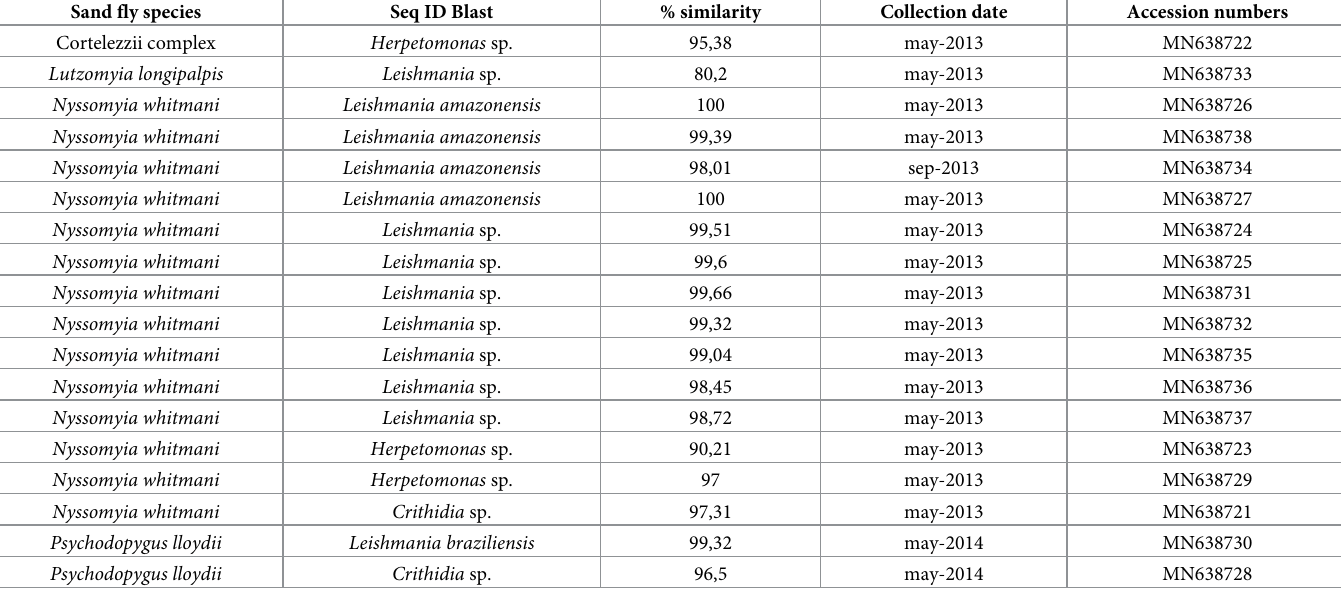
Table 3. Results of DNA detection and identification of species of Trypanosomatidae according to species of sand fly, number of pool and collection date in Casa Branca, Brumadinho from May 2013 to May 2014. Sand fly